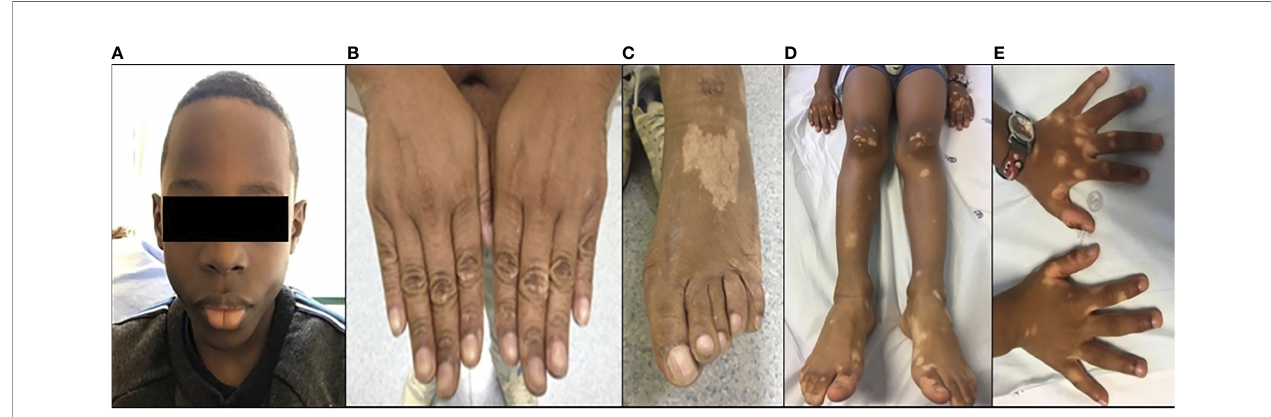
FIGURE 1 | Clinical features: (A) microcephaly in P1; (B, C) hypopigmented skin lesions in P2; and (D, E) hypopigmented skin lesion in P3.